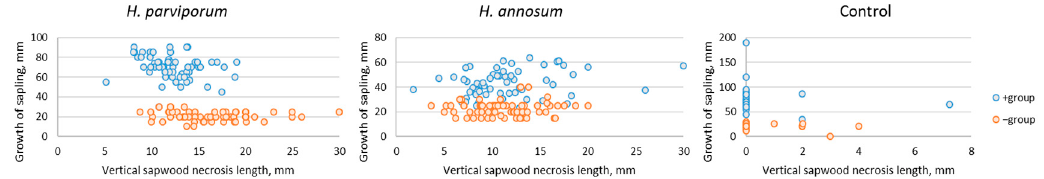
Figure 4. Length of necrosis (mm) observed after inoculation experiment with mock-inoculated control, H . annosum and H . parviporum in Norway spruce saplings in different water availability groups. Averages of vertical ( a , b ) and horizontal ( c , d ) length (mm) of necrosis in sapwood ( a , c ) and phloem ( b , c ) measured to the nearest 0.001 mm.